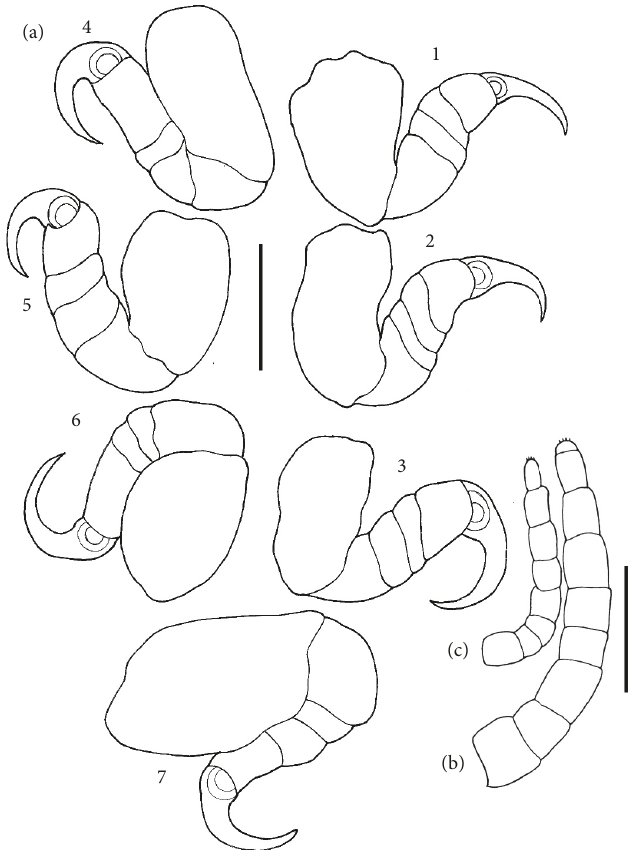
Figure 3: Pereopods of Cymothoa excisa collected from Lutjanus analis , 1-7 represent pairs of perionites that end in strong prehensile claws. Bar: 1 mm. (b) and (c) antenna and antennula, respetively, bar: 0.5